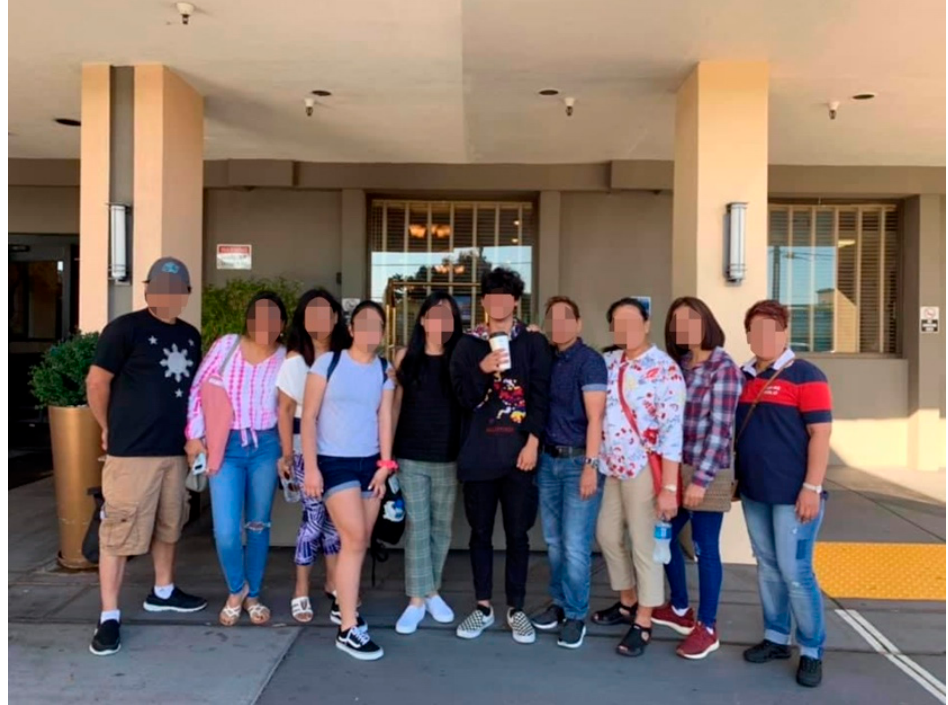
Figure 3 . Sarah’s photo 2019, “not just cousins, but more like family, really!” .